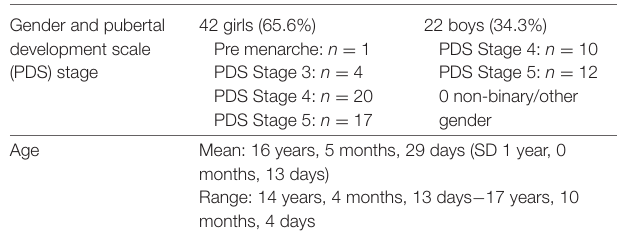
TABLE 1 | Demographic variables: participants’ gender, pubertal development, and age. Gender and pubertal development